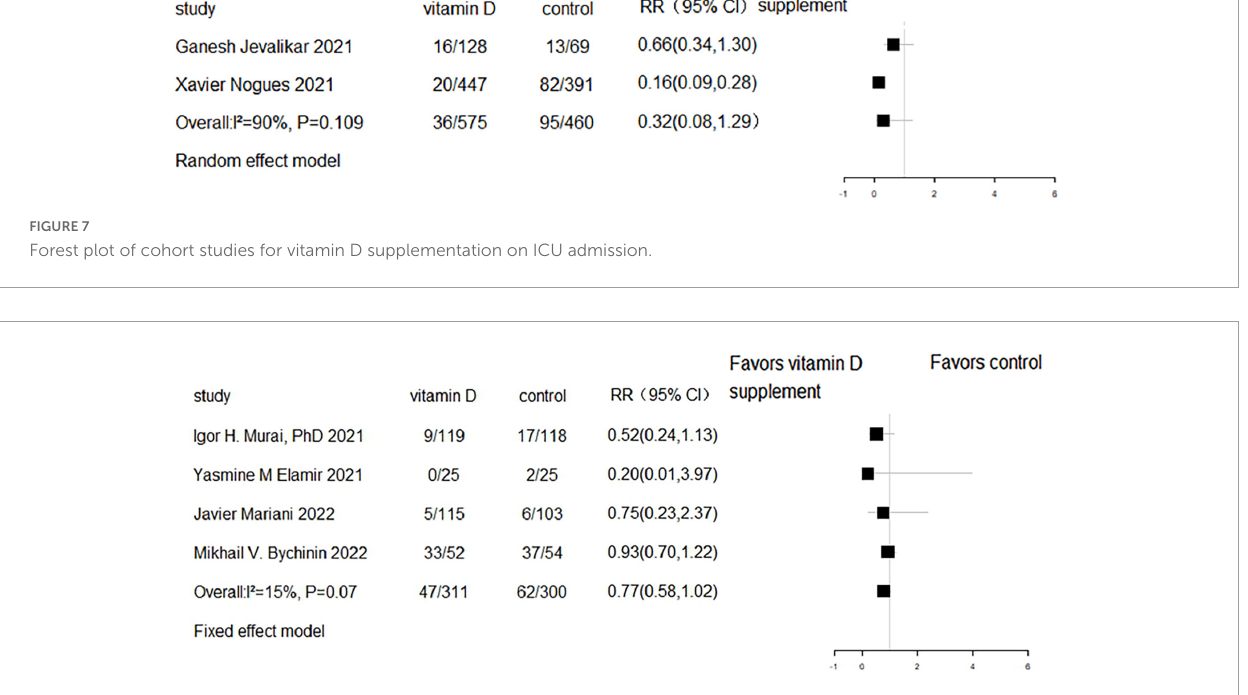
FIGURE8 Forest plot of RCTs for vitamin D supplementation on mechanical ventilation or intubation.